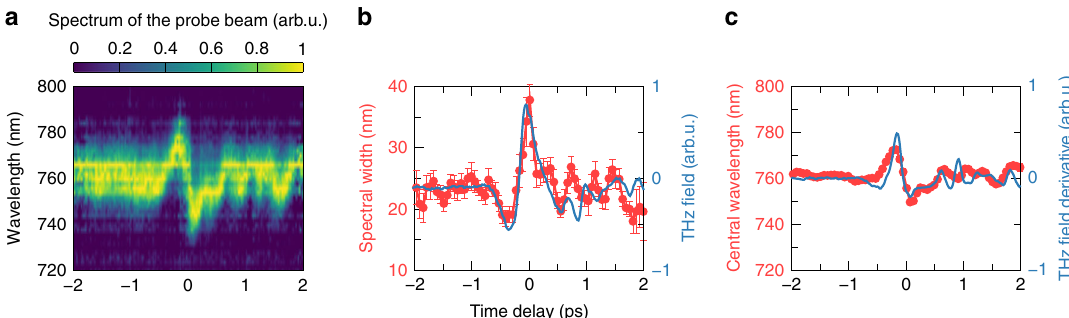
Fig. 6 THz fi eld induced cross phase modulation. a Spectrum of the probe beam as a function of the time delay between the THz and probe pulses. Spectral width b and central wavelength c of the probe pulse (red dot-lines) together with the THz fi eld and the fi rst time derivative of the THz fi eld, respectively, (blue lines) as a function of the time delay between the THz and probe pulses. Error bars represent the standard deviation.